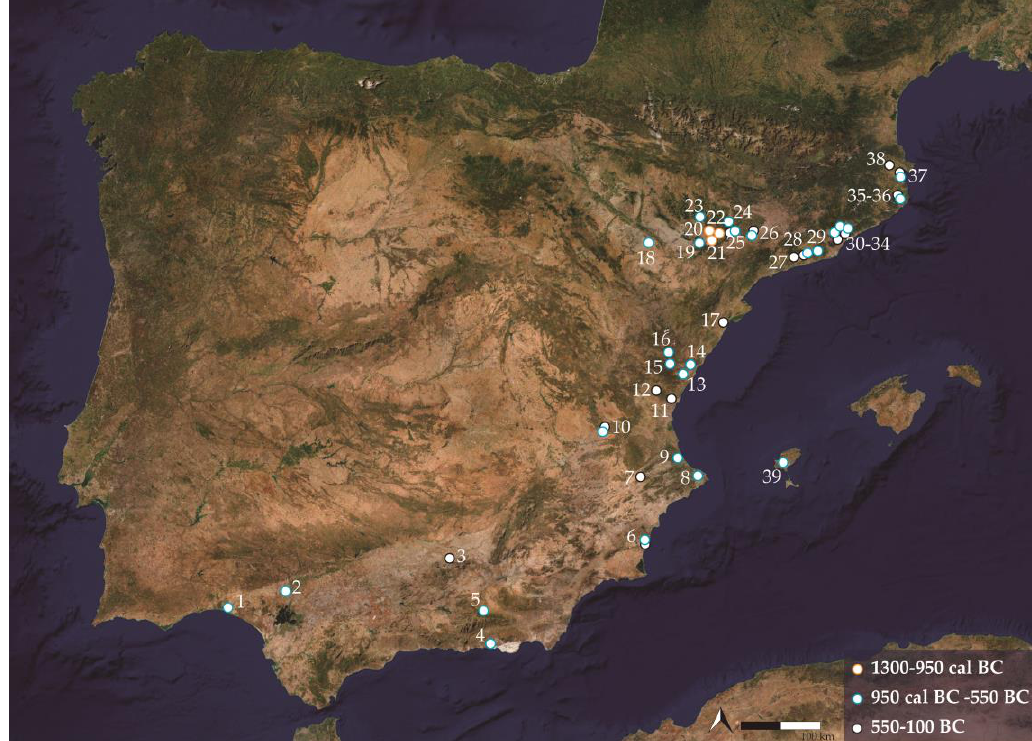
Figure 1. Map indicating the position of sites yielding broomcorn or foxtail millet: 1, Huelva